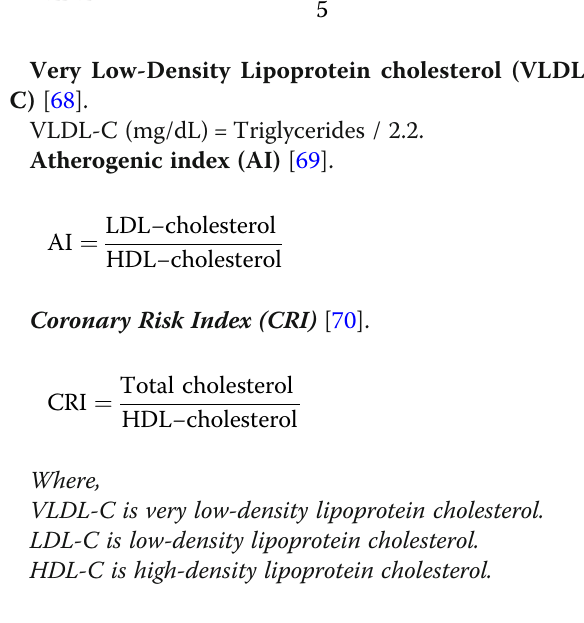
Table 1 Proximate composition (g/100 g DM), energy value (Kcal/100 g) and minerals (mg/100 g) of plantain, soycake, rice-bran and oat-bran flour blends and control